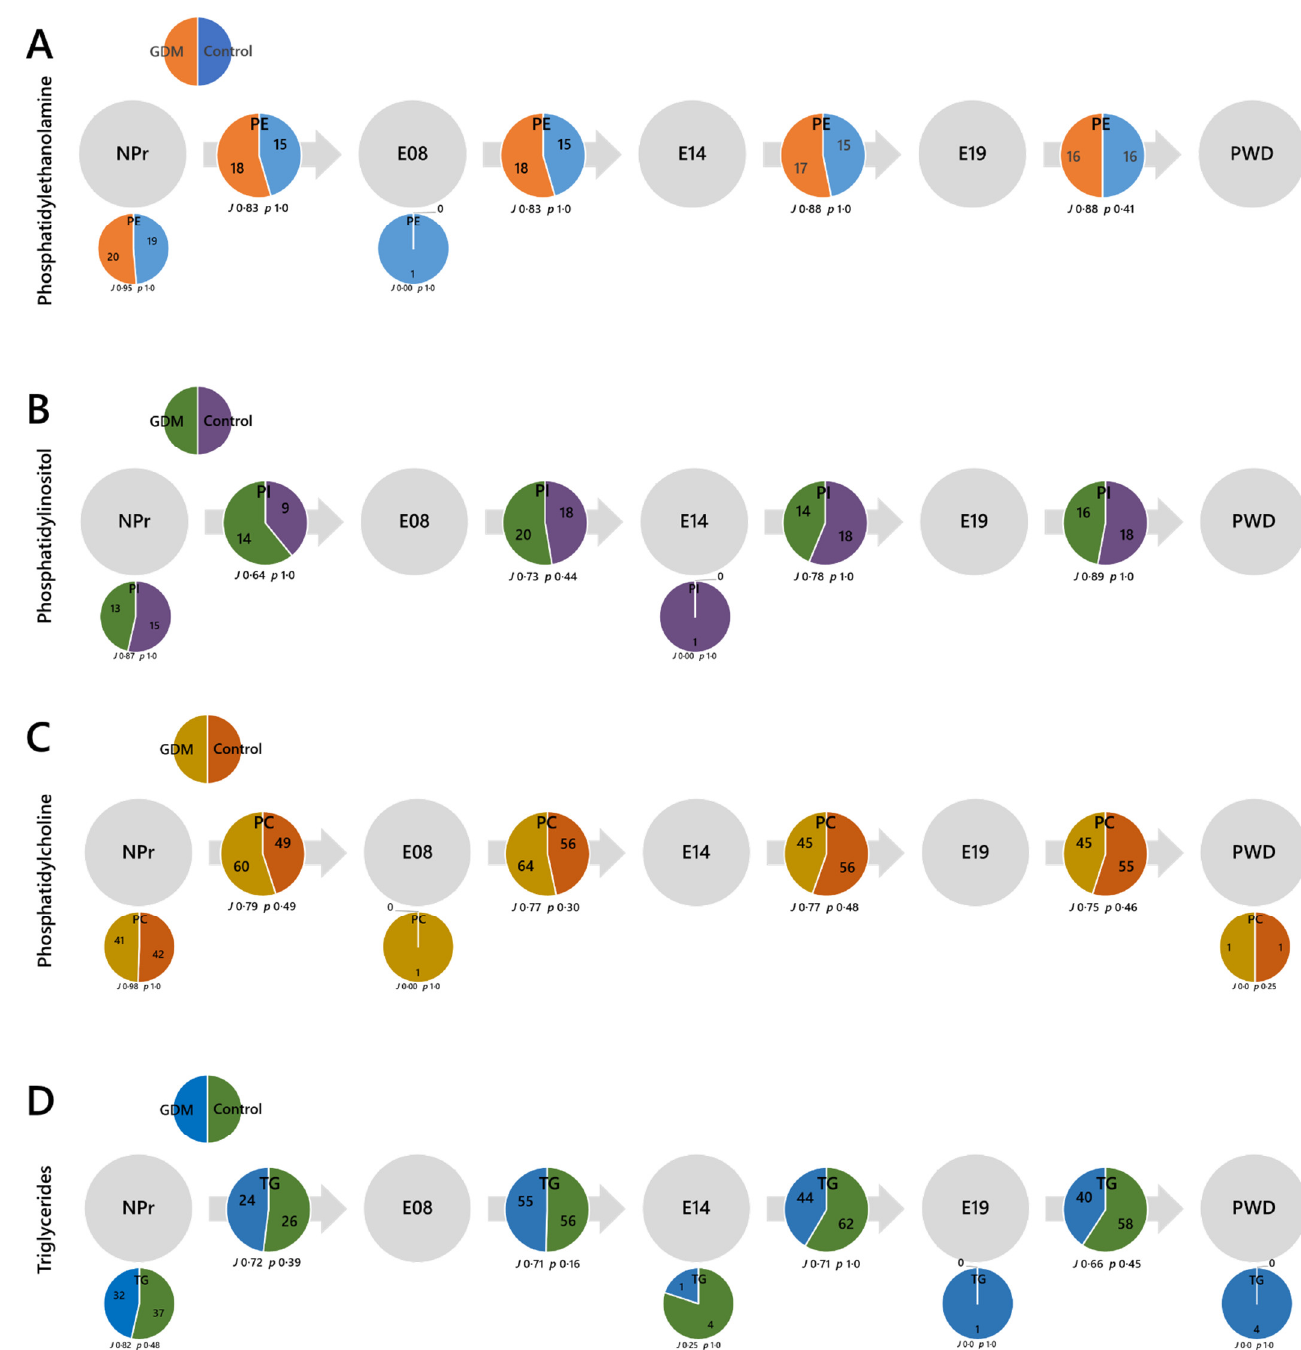
Figure 5. Switch analyses of phosphatidylethanolamine (PE), phosphatidylinositol (PI), phosphatidylcholine (PC) and triglyceride (TG) classes from before conception to after weaning. ( Panel A ) PE; ( B ) PI; ( C ) PC; ( D ) TG. U -type variables are shown in small pie charts under the appropriate time point, where found. B -type lipids are shown in pie charts on the arrow between the appropriate time points. A -type variables: TGs (22:18, J 0 · 82, p 1 · 0); PEs (14:16, J 0 · 88, p 1 · 0); PCs (45:40, J 0 · 81, p 0 · 49); PIs (9:10, J 0 · 90, p 1 · 0). NPr, not pregnant; E08, 8th day of pregnancy; E14, 14th day of pregnancy; E19, 19th day of pregnancy; PWD, post-weaning